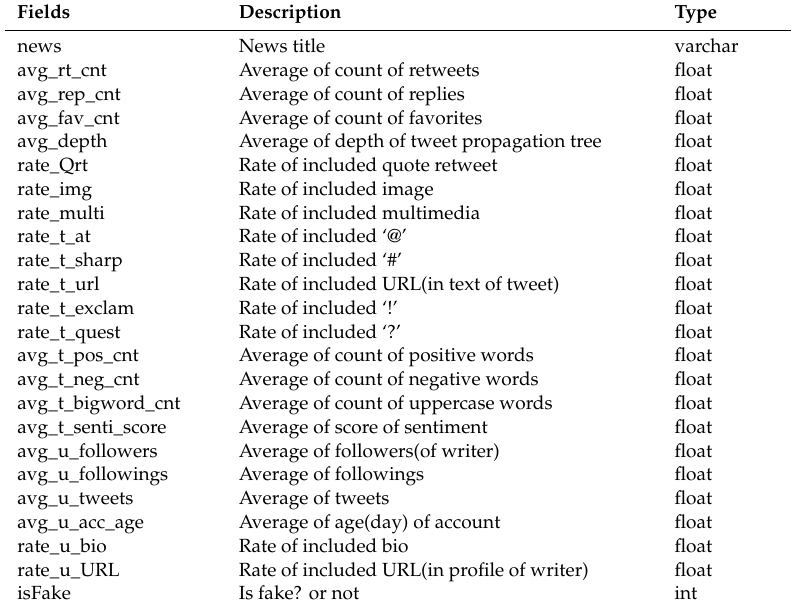
Table 2. Aggregation of variables by news (the schema of